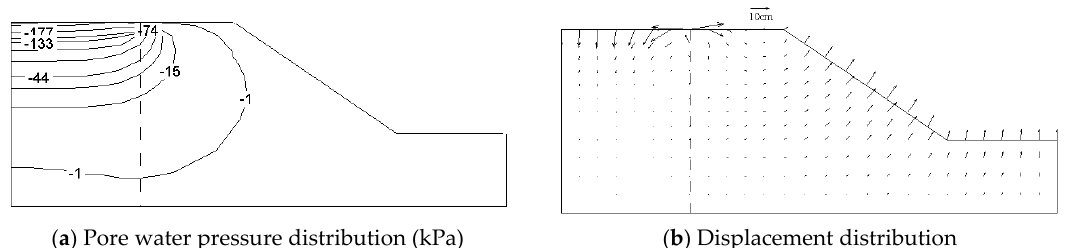
Figure 4. The distributions of pore water pressure and displacement at the end of evaporation of baseline group.